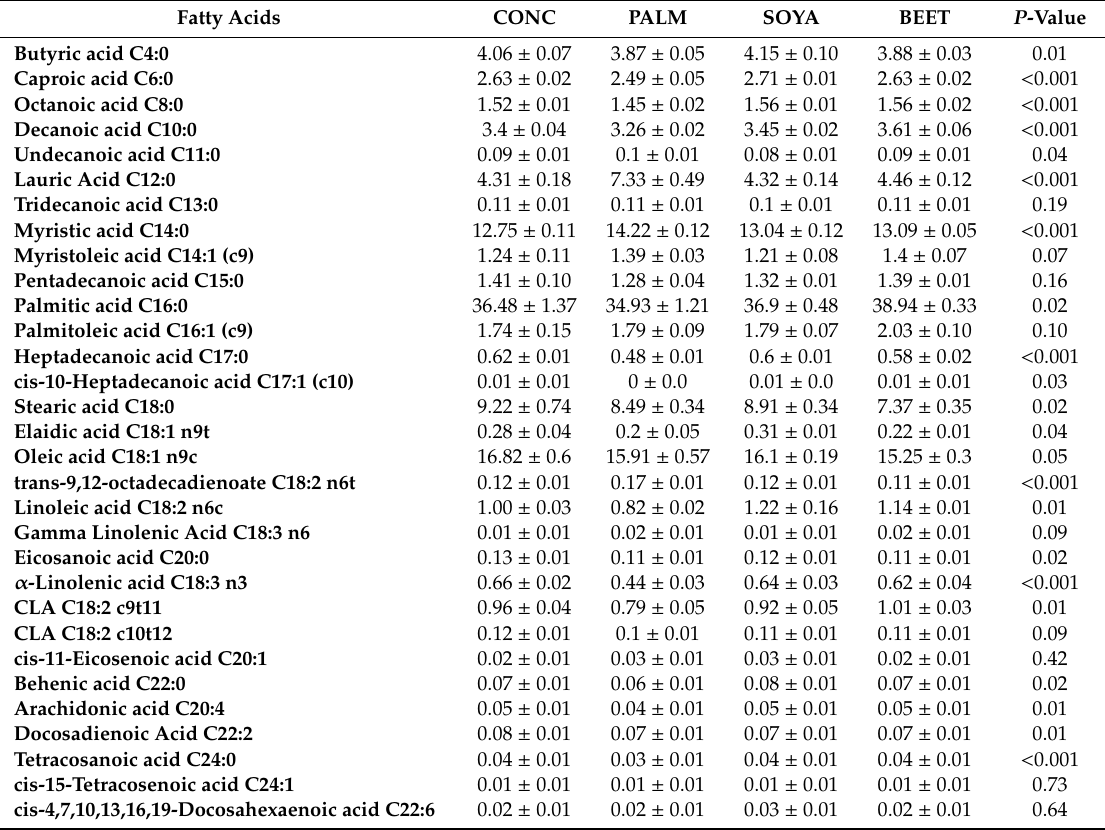
Table 7. Milk fatty acid composition (g / 100g of FA) from cows feed pasture diets supplemented with CONC, PALM, SOYA, or